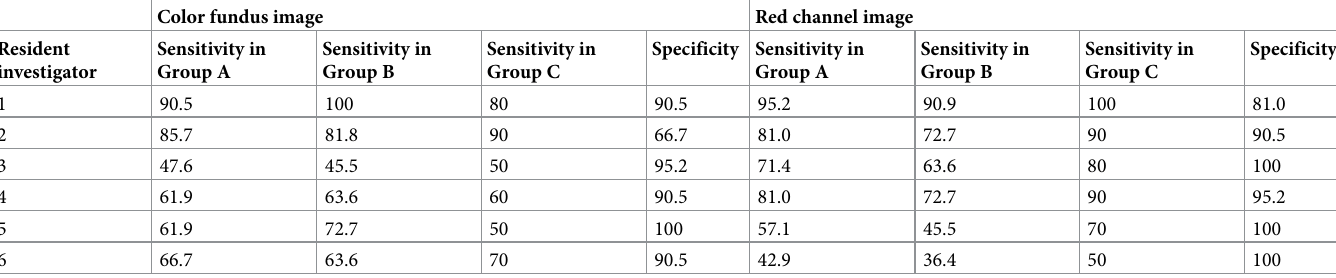
Table 2. Sensitivity and specificity of two imaging modalities for detecting the ischemic status in patients with CRVO. Color fundus